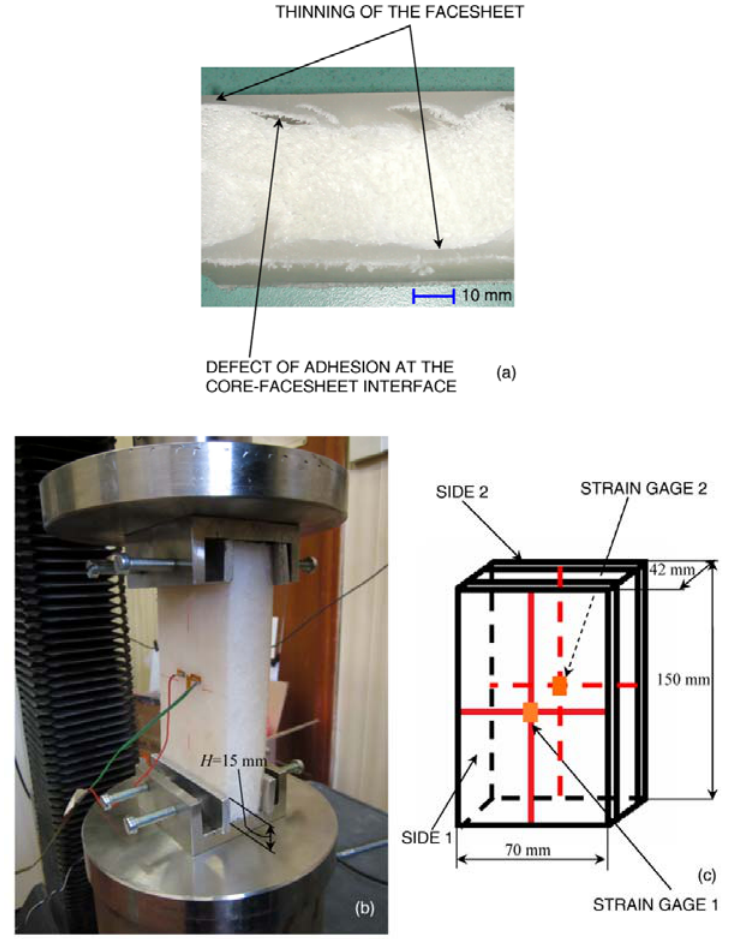
Figure 1. ( a ) Facesheet thinning and core-facesheet adhesion defects; ( b ) loading frame utilized for edgewise compression tests; and ( c ) specimen schematic with indication of strain gage